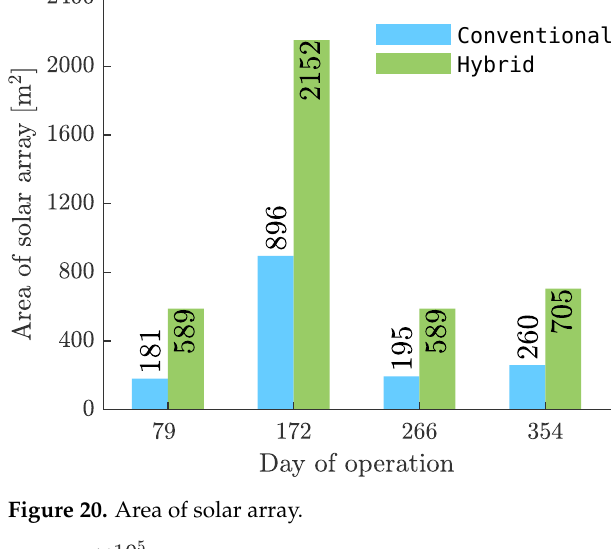
Figure 20. Area of solar array.